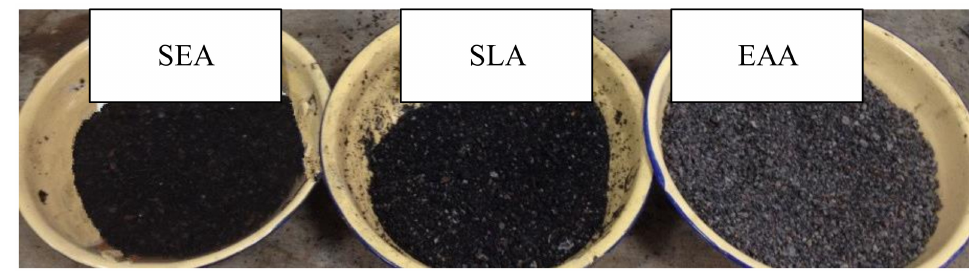
Figure 3. Damping aggregate used in this study.